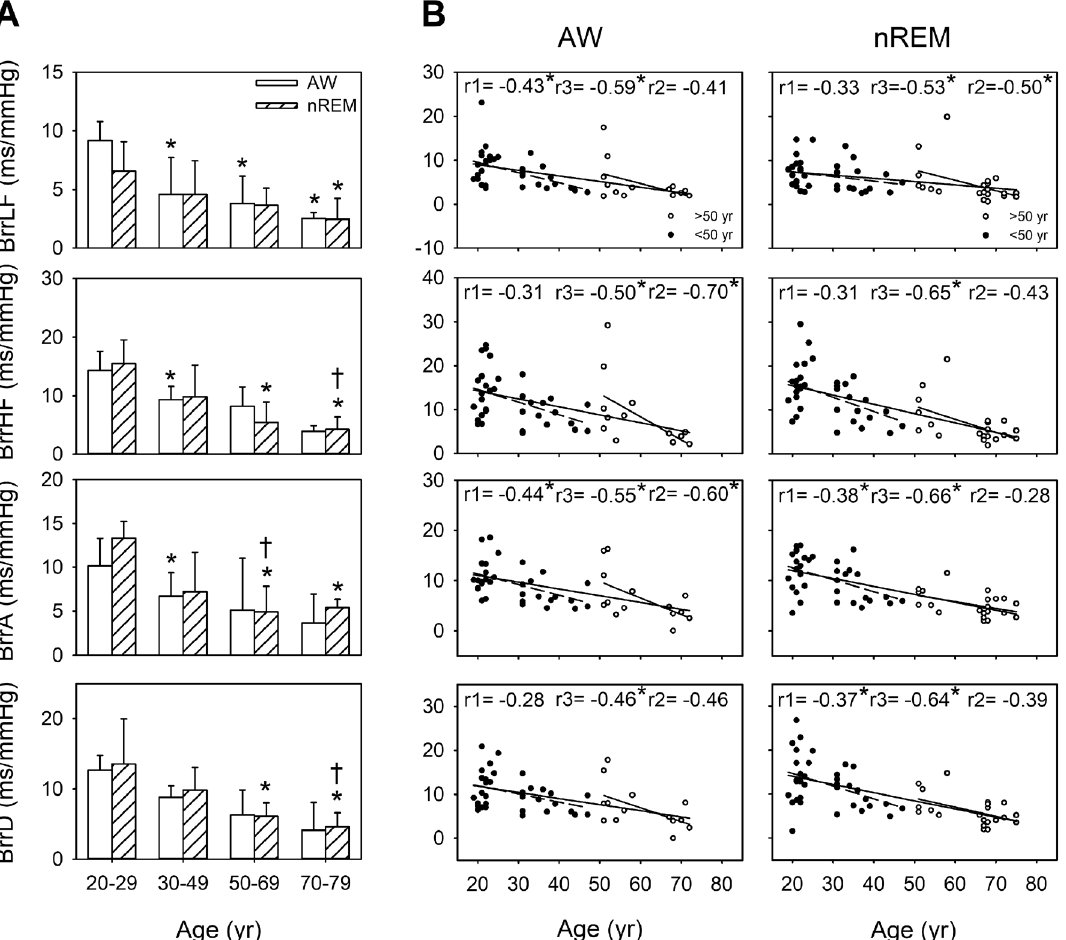
Figure 2. Baroreflex sensitivity (BRS) parameters during wakefulness (AW) and non-rapid eye movement sleep (nREM) in the different age groups in all participants and their comparison for different consciousness states ( A ). * p < 0.05 vs. 20–29-year age group. † p < 0.05 vs. 30–49-year age group. The values are presented as means ± SEMs. Two-dimensional scattergrams for the BRS–age relationship during AW and nREM in all participants ( B ). * p < 0.05. r1: correlation coefficient in the 20–49-year age group. r2: correlation coefficient of 50–79-year age group. r3: correlation coefficient of 20–79-year age group. Abbreviations: BrrHF/BrrLF, magnitude of the MAP–R-R interval transfer function; BrrA/BrrD, slopes of MAP–R-R interval linear BrrA (r = − 0.38, p = 0.023) and BrrD (r = − 0.37, p = 0.028) demonstrated a more considerable decline in the ear- lier life stages than did BrrLF. Moreover, the age-related decline in BRS (i.e., BrrLF, BrrHF, BrrA, and BrrD) was more apparent during nREM (r = − 0.53, − 0.65, − 0.66, and r = − 0.64, respectively; all p < 0.001) than during AW (r = − 0.59, p < 0.001; r = − 0.50, p < 0.001; r = − 0.55, p < 0.001; and r = − 0.46, p = 0.001, respectively). Therefore, BRS indexes during sleep are a vital indicator of the effect of age on BRS (Fig. 2). Comparison of BP/APV between sexes during different consciousness states across different age groups. Changes in BP with aging were more notable during nREM than during wakefulness. A sig- nificant correlation was noted between BP and age both during wakefulness and nREM in women (r = 0.50, p = 0.006 and r = 0.41, p = 0.018, respectively); however, this correlation was noted only during nREM in men (r = 0.48, p = 0.020). If we examine all the participants aged 20–79 years, BP during nREM was observed to have a moderate to strong relationship with age both in the men and women (r = 0.48, p = 0.020 and r = 0.41, positively correlated with age in the women aged 20–79 years and those aged 50–79 years (r = 0.62, p < 0.001 and r = 0.75, p = 0.002, respectively); however, this result was not observed in the men. During wakefulness, significant sex differences were noted. Among the individuals aged 20–29 years, BLF was higher in the men than in the women ( p = 0.037). During nREM, BHF was positively correlated with age among the women (r = 0.55, p = 0.001) and men (r = 0.55, p = 0.007) of all ages and in the women aged 50–79 years (r = 0.66, p = 0.011). Finally,